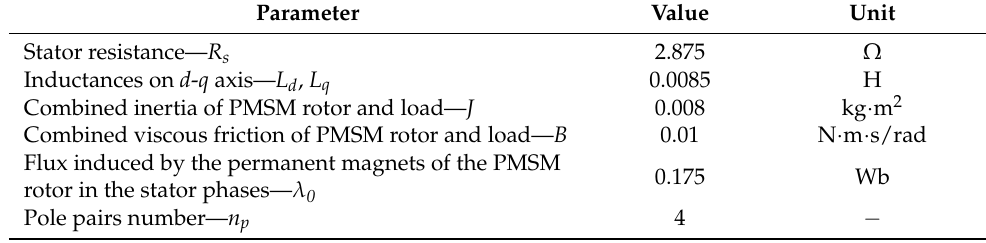
Table 1. PMSM nominal parameters.